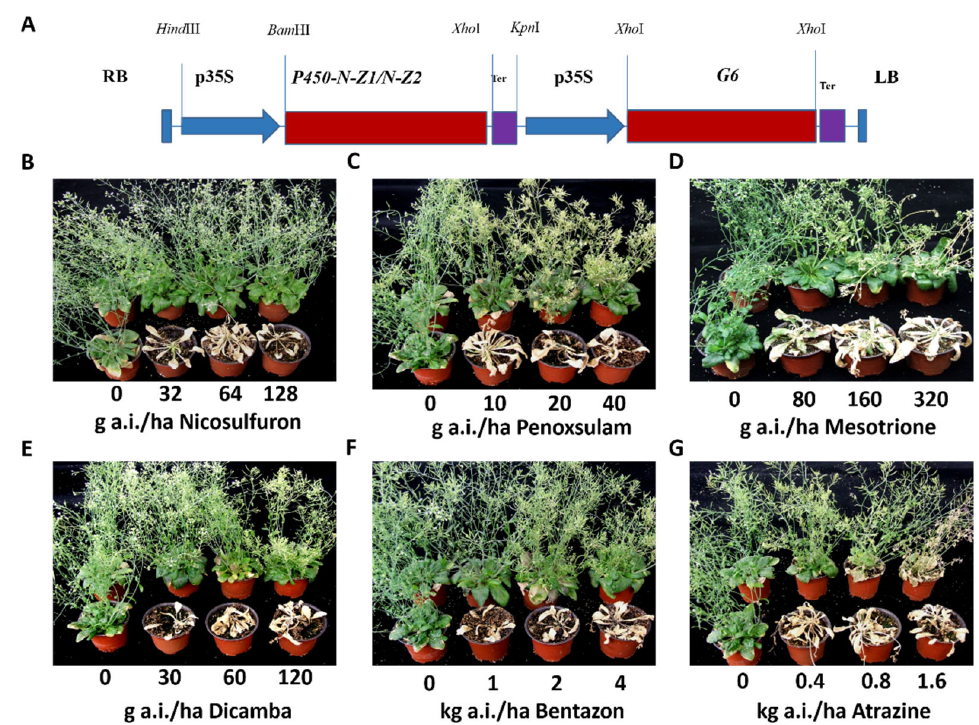
Figure 1. Herbicide tolerance assays of Arabidopsis transformed with T-DNA with P450-N-Z1 expression cassette. ( A ) The diagram of the T-DNA for Arabidopsis transformation. ( B ) P450-N-Z1 transgenic Arabidopsis challenged with nicosulfuron. ( C ) P450-N-Z1 transgenic Arabidopsis challenged with penoxsulam. ( D ) P450-N-Z1 transgenic Arabidopsis challenged with mesotrione. ( E ) P450-N-Z1 transgenic Arabidopsis challenged with dicamba. ( F ) P450-N-Z1 transgenic Arabidopsis challenged